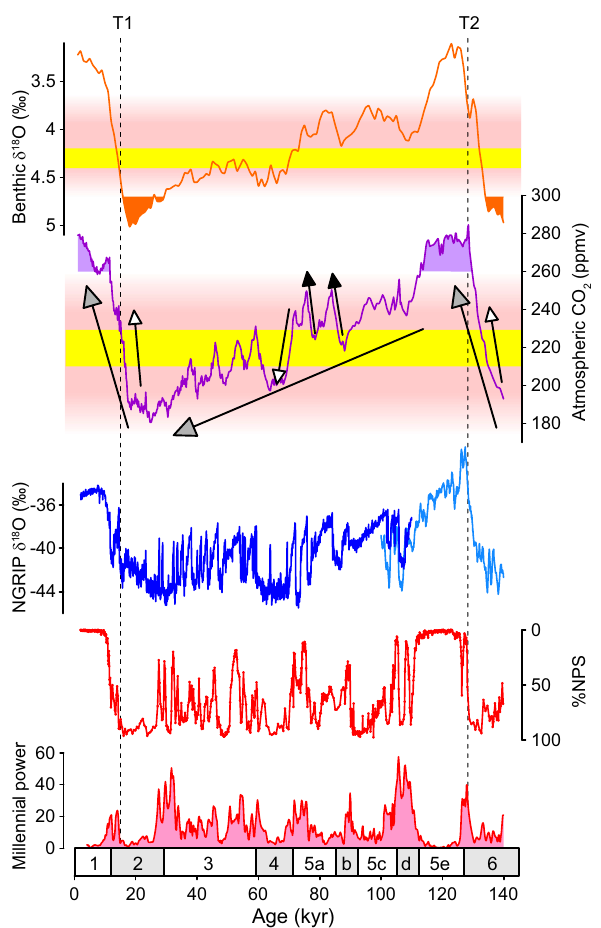
Fig. 3 Feedbacks between millennial and orbital-timescale variability. From top to bottom: Benthic δ 18 O 65 ( fi lled regions indicate monostable AMOC as a function of maximum ice volume); Atmospheric CO 2 97 ( fi lled regions indicate monostable AMOC as a function of high CO 2 ); Greenland ice-core δ 18 O 99 with synthetic record 27 beyond 110ka; %NPS (temperature proxy) from ODP Site 983; Millennial activity at Site 983 (see text). Pink and yellow shaded boxes represent the window of opportunity and sweet spot respectively (see Fig. 2). Grey headed arrows represent orbital- timescale trends in atmospheric CO 2 ; Black (white) headed arrows represent examples of negative (positive) feedback of millennial-scale variability on orbital changes. Feedbacks are strongest within the sweet spot. Dashed vertical lines indicate timing of AMOC recovery associated with glacial terminations T1 and T2. Lower numbers are Marine Isotope